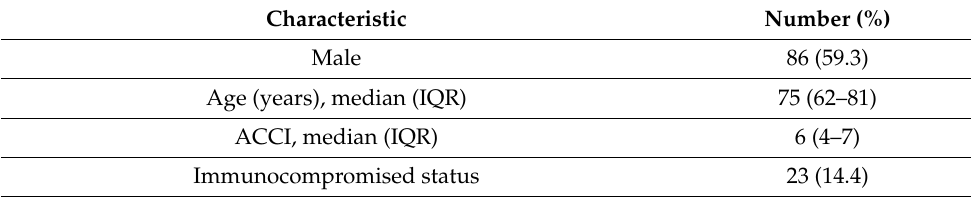
Table 1. Characteristics and outcomes of patients with ampicillin-susceptible enterococci blood- stream